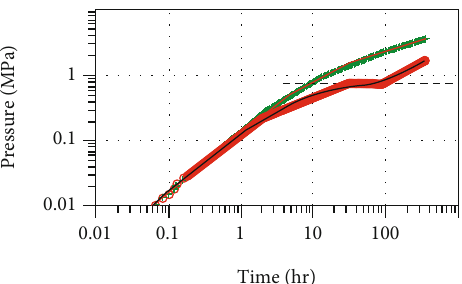
Figure 9: Pressure drop curve characteristics of typical well test, well A.